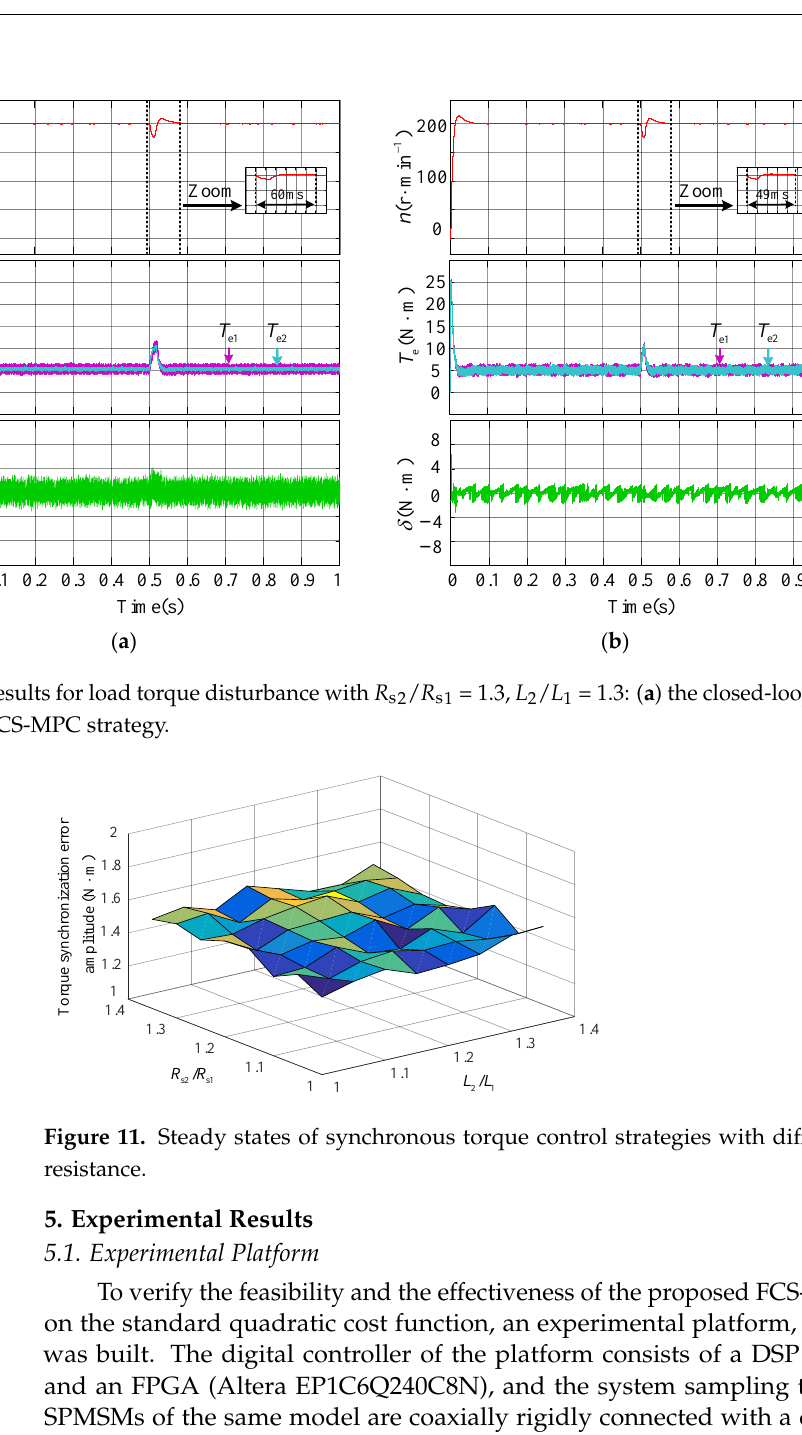
Figure 11. Steady states of synchronous torque control strategies with different inductance and re- sistance.